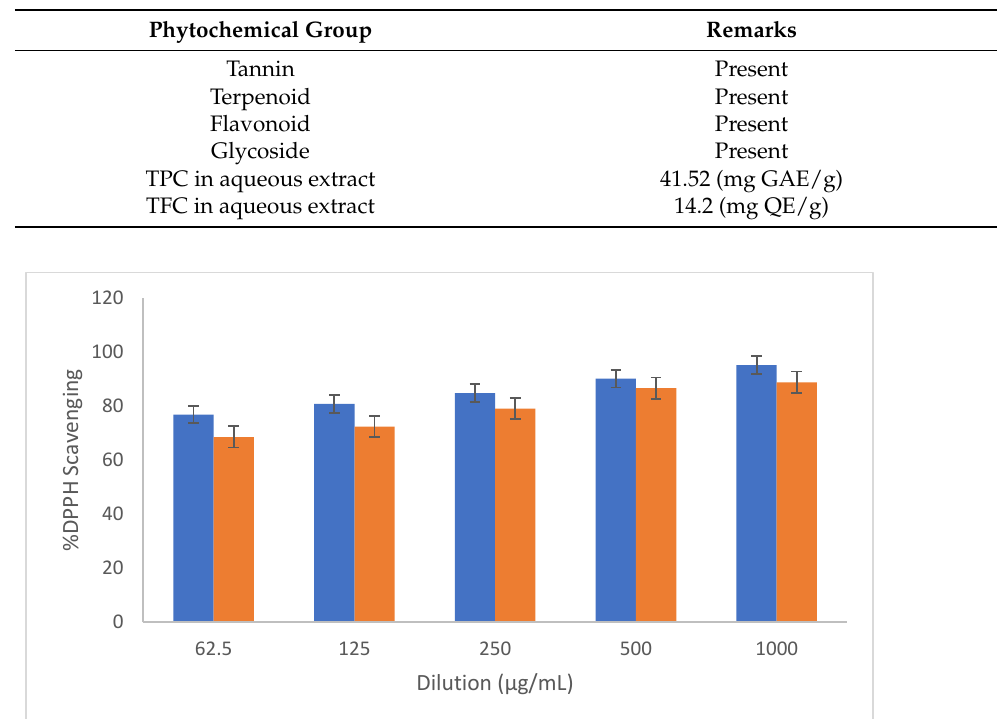
Table 1. Representative phytochemical groups present, total phenolic and flavonoid contents in the leaf extract of E. wallichii .